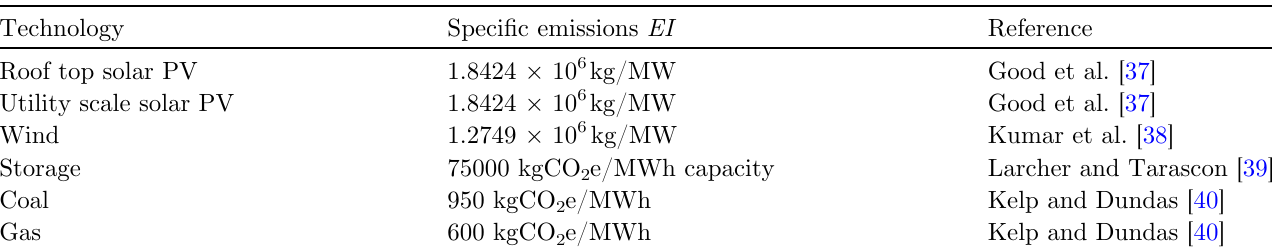
Table 2. Speci fi c emission intensities and plant lifetimes for different energy generation and storage technologies.